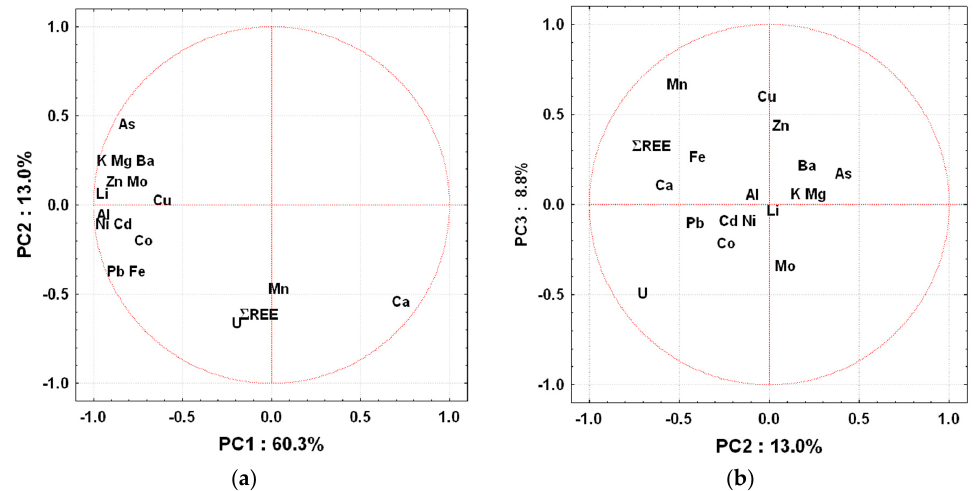
Figure 4. Principal component analysis (PCA) loadings plots: ( a ) principal component (PC)1 vs. PC2, ( b ) PC2 vs. ( b ) PC2 vs. PC3.